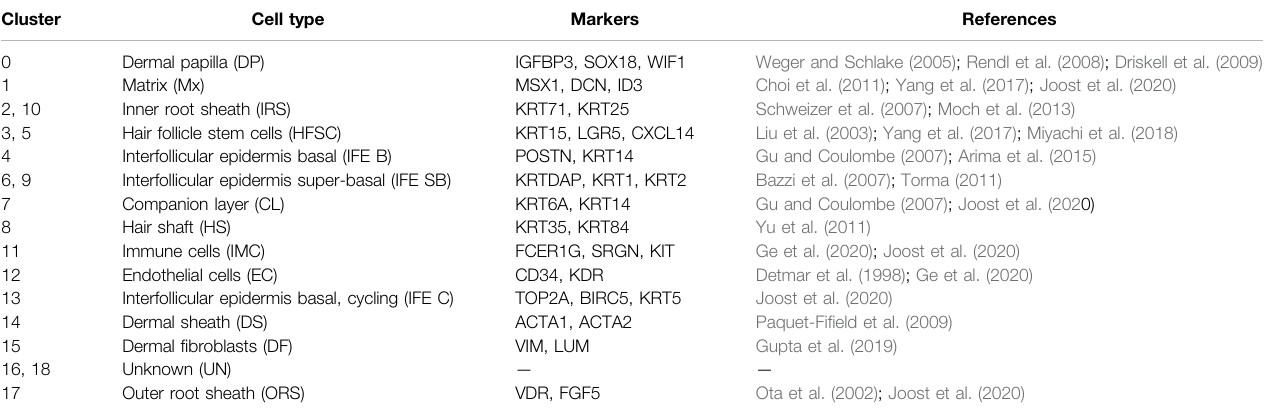
TABLE 2 | Cell types and their corresponding marker genes analyzed from